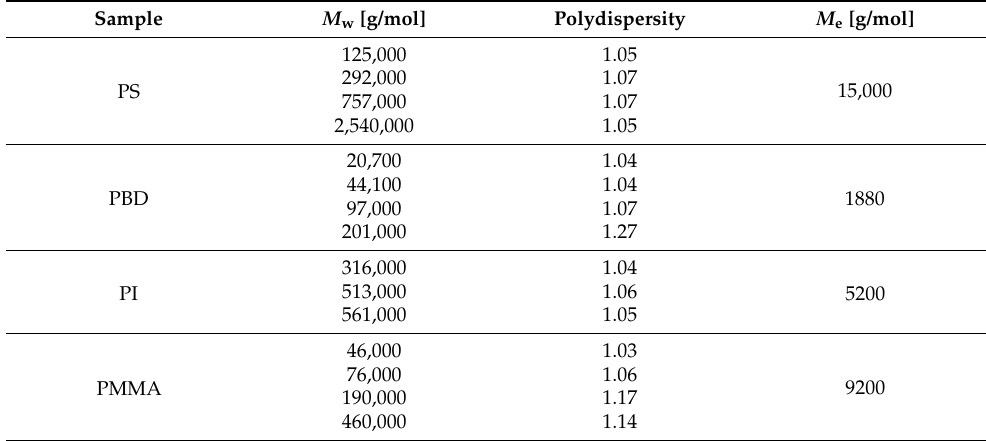
Table 1. Specifications of